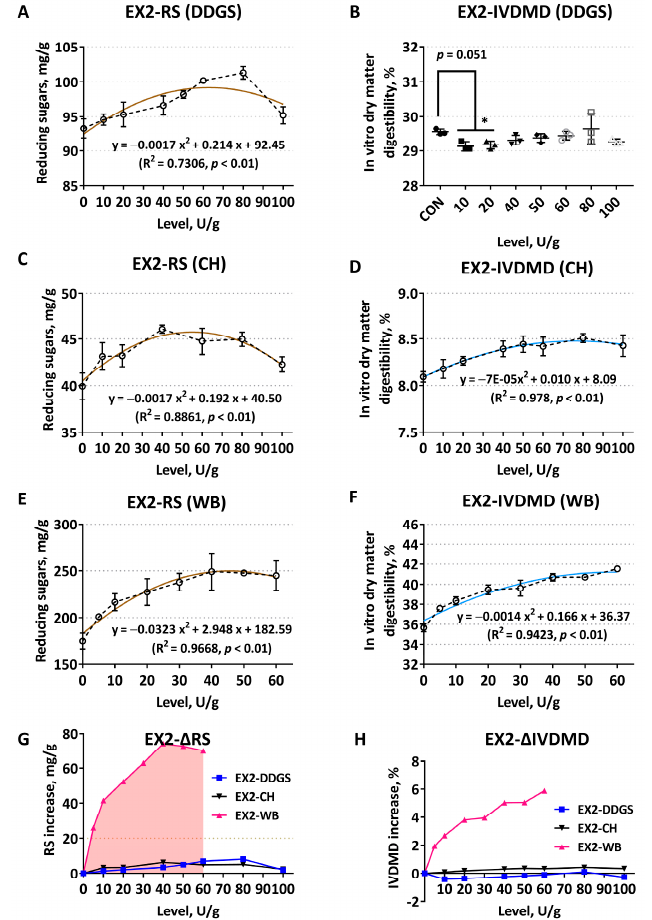
Figure 2. Comparison of enzymatic hydrolysis effects of Trichoderma derived xylanase EX2 on differ- ent feed ingredients. It was determined by the release of reducing sugars (RS) and the improvement of in vitro dry matter digestibility (IVDMD). ( A , B ) Corn–soybean meal basal substrates mixed with 5% DDGS; ( C , D ) unitary corn hull (CH) substrate; ( E , F ) unitary wheat bran (WB) substrate; ( G , H ) comparison of the net increase in RS release ( Δ RS, mg/g) and dry matter digestibility ( Δ IVDMD, %), respectively. Polylines directly explain the actual variability of each indicator. The dark brown curves in the scatter plot display the RS trend, while the light blue represents the fit of IVDMD. The data are expressed as the means ± SD. The asterisk (*) in this Figure 2B indicates that the corresponding response index values of the enzyme treatment groups are significantly different from the blank control (CON).